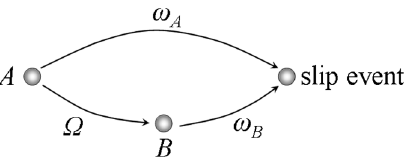
FIG. 1. Basic scheme of the contact-strengthening model from the main